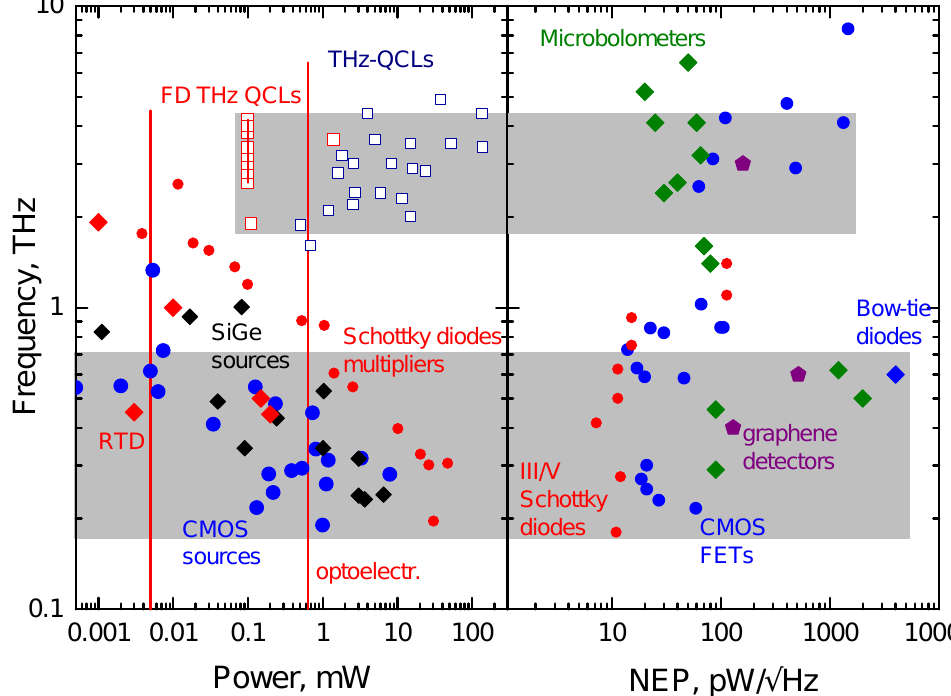
Figure 9. Map of room temperature emitting and sensing devices in a logarithmic THz frequency scale. The considered devices are plotted with respect to the emitting power in sources section (left) and the noise equivalent power ( NEP ) in sensors one (right). Taken data references: Schottky diodes multipliers [87,439] CMOS-based and SiGe-based electronic emitters [62]; CMOS and SiGe detectors parameters [159], parameters of Schottky detectors [440], microbolometers values [167], conventional THz QCL [41]; frequency-difference THz QCLs (FD THz QCLs) parameters—from publications by M. Razeghi [51,52] and M. Belkin’s [53] groups. Optoelectronic THz systems (denoted as red solid lines) are attributed for the emitters section only. The left red solid line depicts facilities of optoelectronic InGaAsBi-based systems [36], the right one—the system relying on InGaAs:Rh compound [37]. Resonant tunneling diodes data are taken from publications by M. Asada [119,121], M. Feiginov [117] and H. Yokoyama [441] groups. Shaded ares denote schematically possible comple- mentary components in a design of compact THz imaging systems in respect to the THz frequency scale. One can note that compact room temperature THz imaging systems can be constructed, for instance, using FD THz QCLs and silicon nanometric transistors or microbolometers. It is seen that RTD devices can be used together with Schottky diodes, silicon nanoFETs, microbolometers and bow-tie diodes [181]. One can mention that CMOS technology-based mixers and oscillators in imaging can be nicely fitted together with nanometric FETs and microbolometers, as well as Schottky or bow-tie diodes. Graphene-based room-temperature THz detector’s parameters are taken from publications of the H. G. Roskos [163], J. Stake [442], and M. S. Vitiello groups